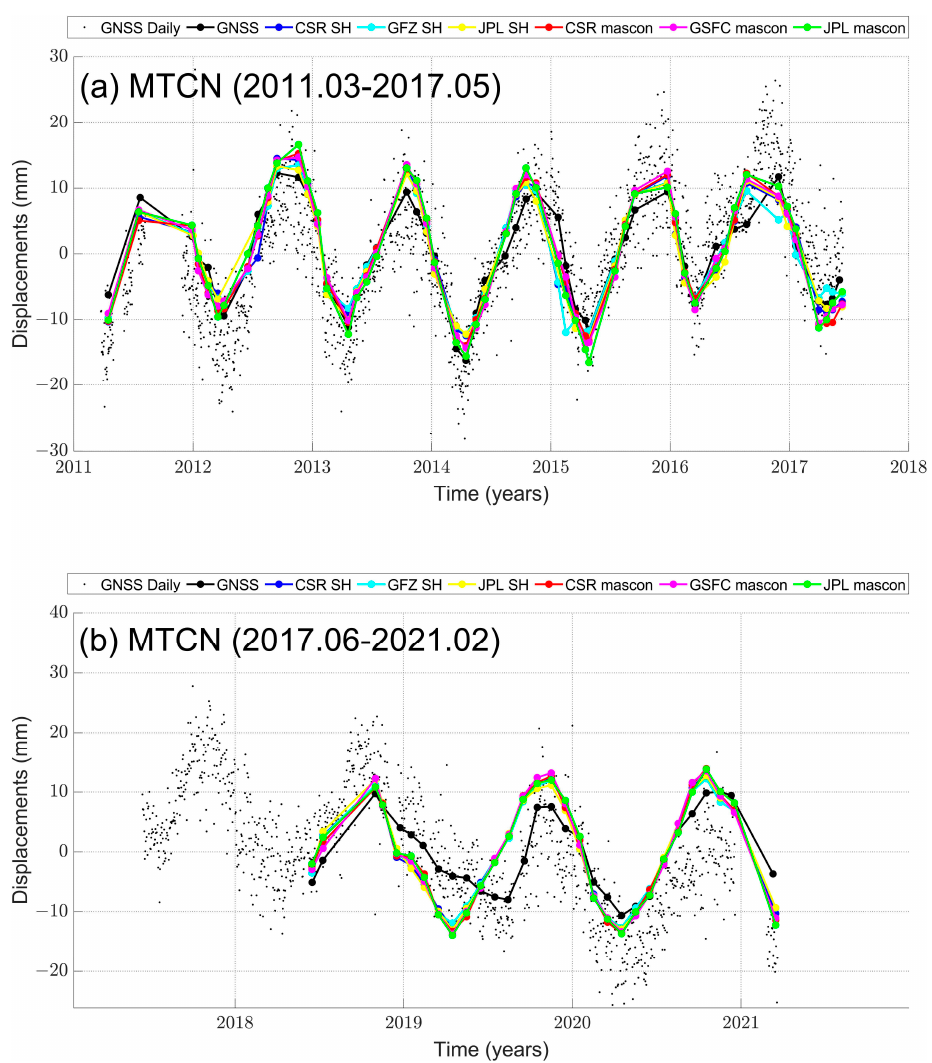
Figure 8. The front and back segments of the time series at the station MTCN in accordance with the time span of GRACE and GRACE-FO: ( a ) before mid 2017, and ( b ) after mid 2017.